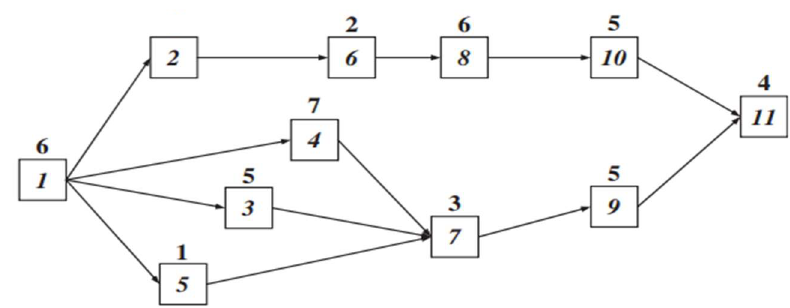
Figure 1. Precedence diagram with assembly network [33].